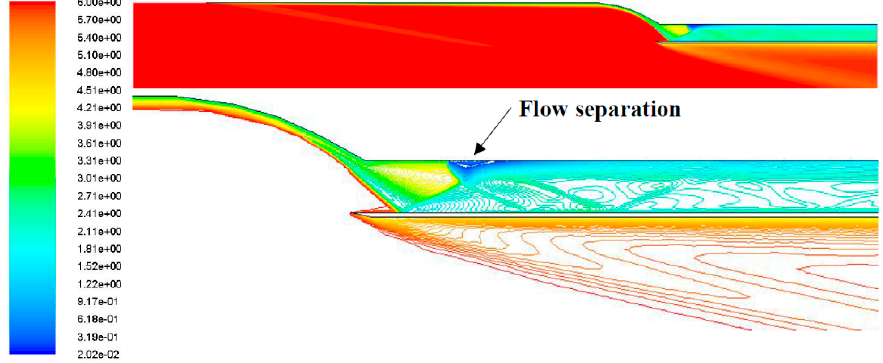
Figure 22. Mach contours of four ramp inlet at Mach 6.